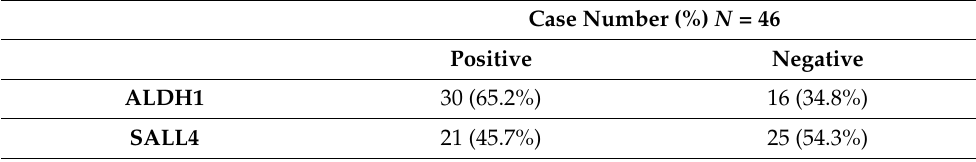
Table 1. Comparative analysis of cells positive and negative for ALDH1 and SALL4 in patients with